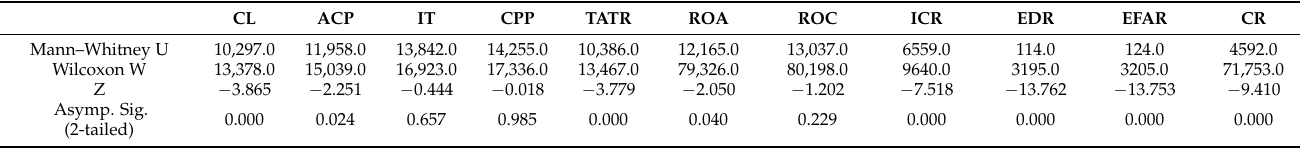
Table 4. Results of Mann–Whitney test.